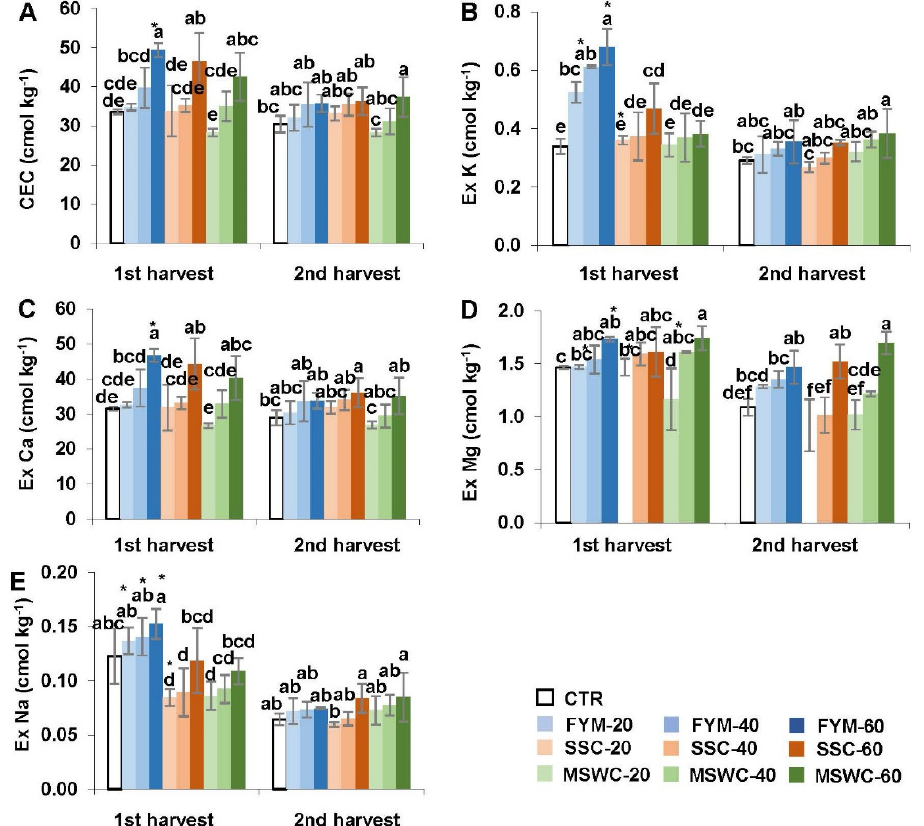
Figure 2. Effects of the three organic waste applications on ( A ) cation exchange capacity, ( B ) exchangeable K, ( C ) exchangeable Ca, ( D ) exchangeable Mg and ( E ) exchangeable Na. Lower case letters indicate significant differences between treatments within the same harvest time. An asterisk indicates significant differences between harvest time within each treatment over time (* p < 0.05).